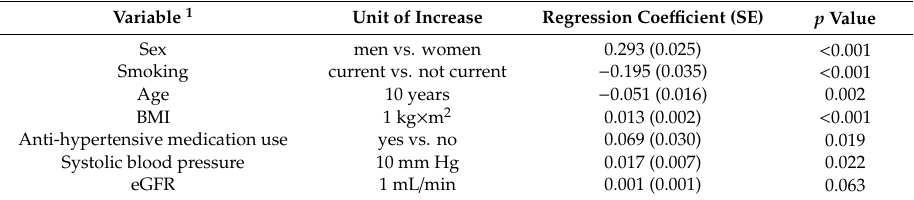
Table 2. Cross-sectional correlates of plasma homoarginine.